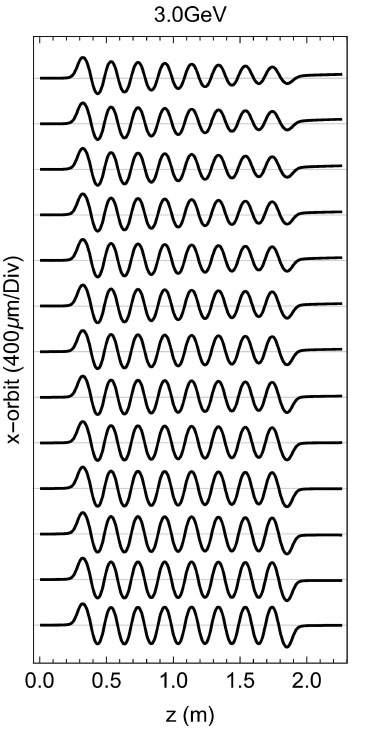
Figure 8 The orbit in the modulator around the maximum K value for different linear taper